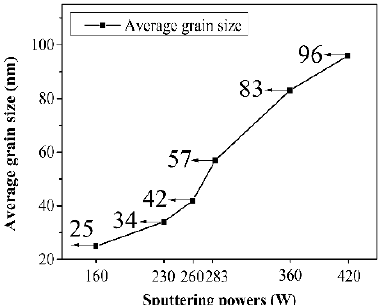
Figure 2. The relationship between the average grain size of the Fe film and the sputtering power.